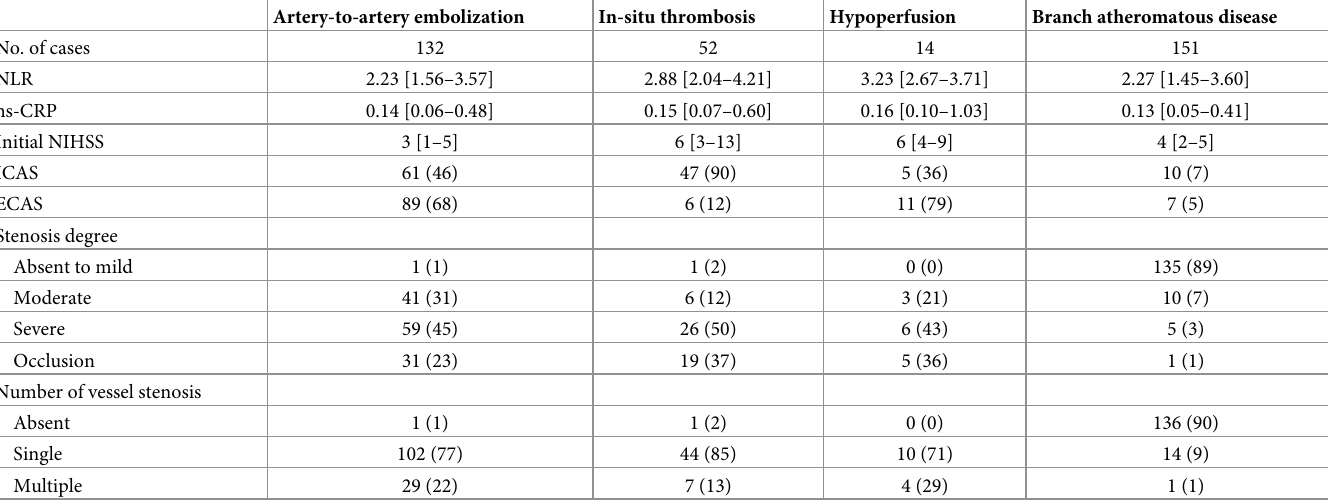
Table 3. Characteristics according to stroke mechanism in patients with large-artery